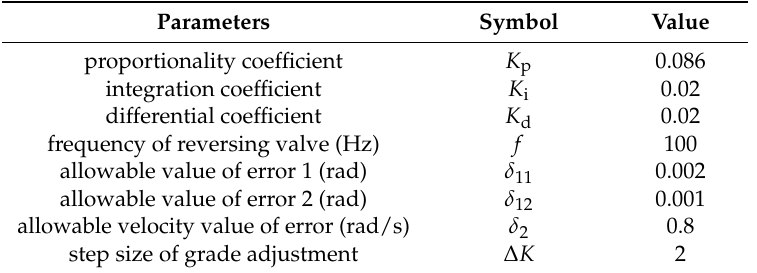
Table 3. The parameter of a hydraulic joint in the control simulation.